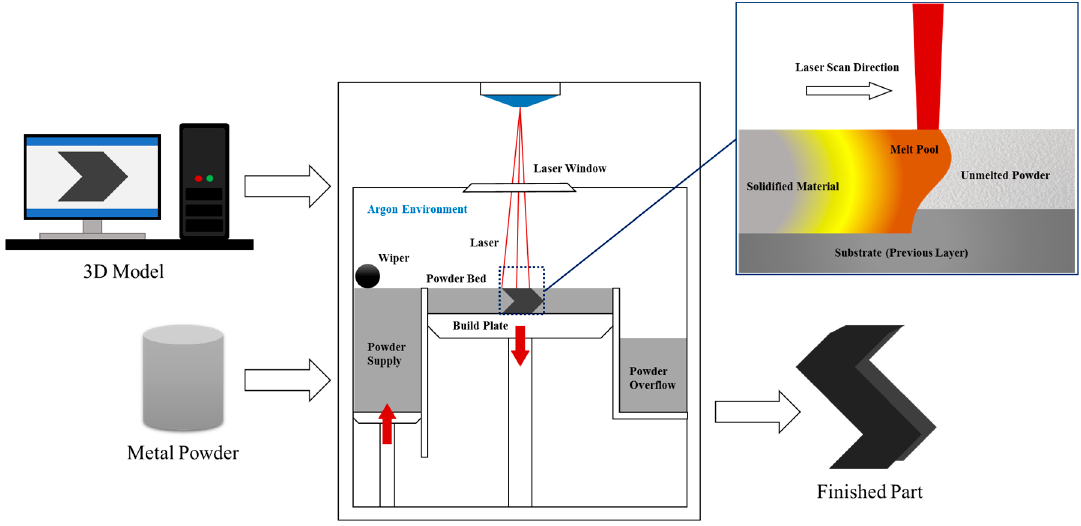
Figure 1. SLM/DMLS process mechanics. Figure 1 . SLM/DMLS process mechanics. Figure 1 . SLM/DMLS process mechanics.